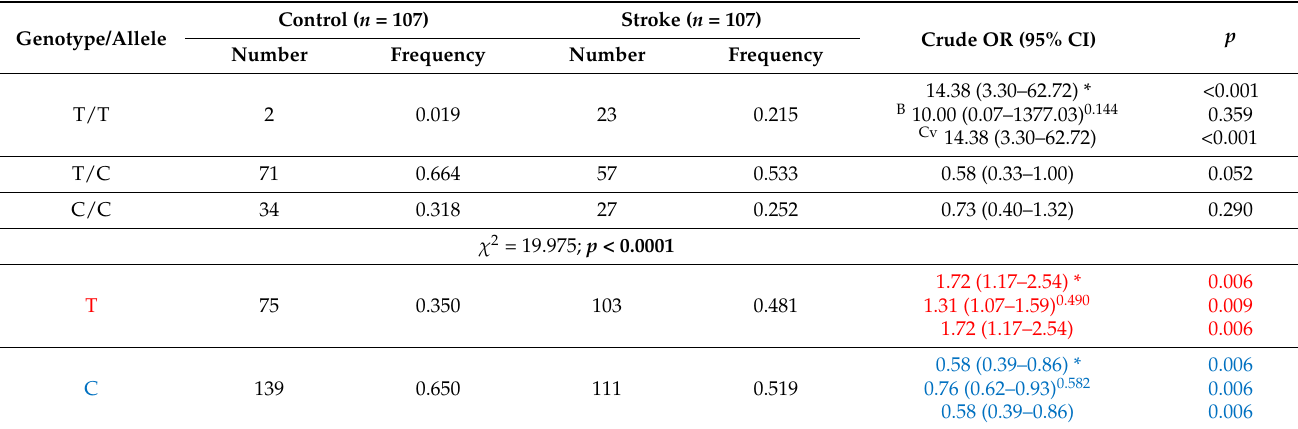
Table 3. Distribution of genotypes and alleles of the c.47T > C (rs4880) polymorphism in the SOD2 gene and odds ratios (ORs) with 95% confidence intervals (95% CIs) in patients with stroke and controls.